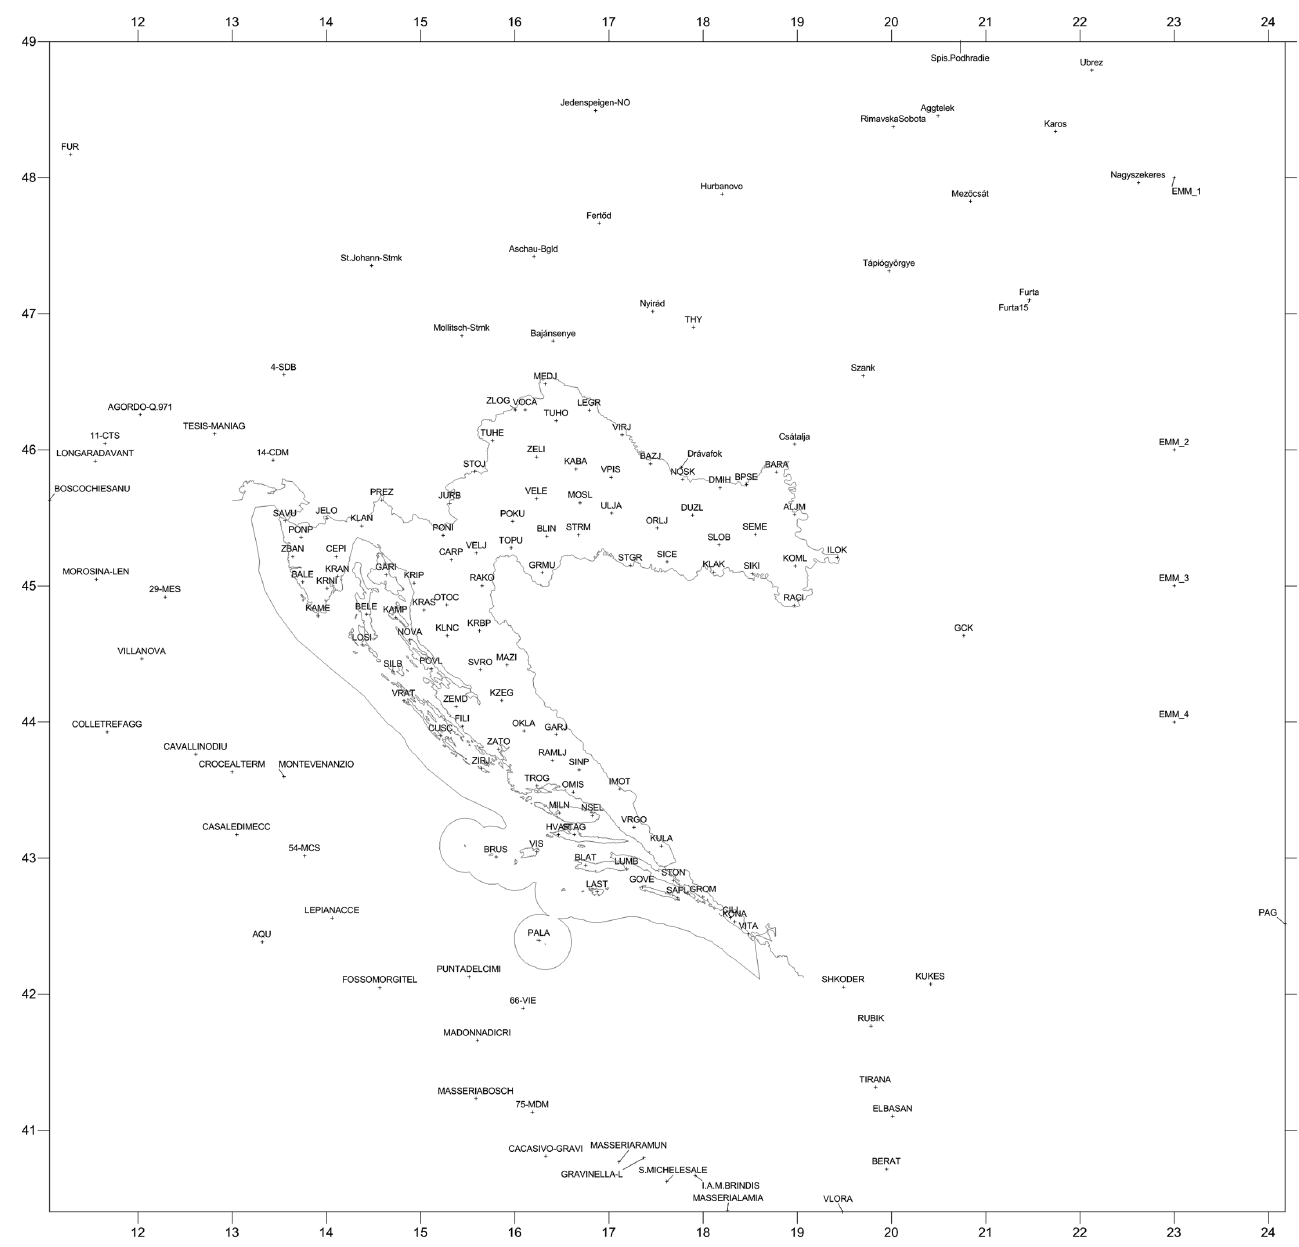
Figure 2. Data points used to obtain 2008.5 geomagnetic field